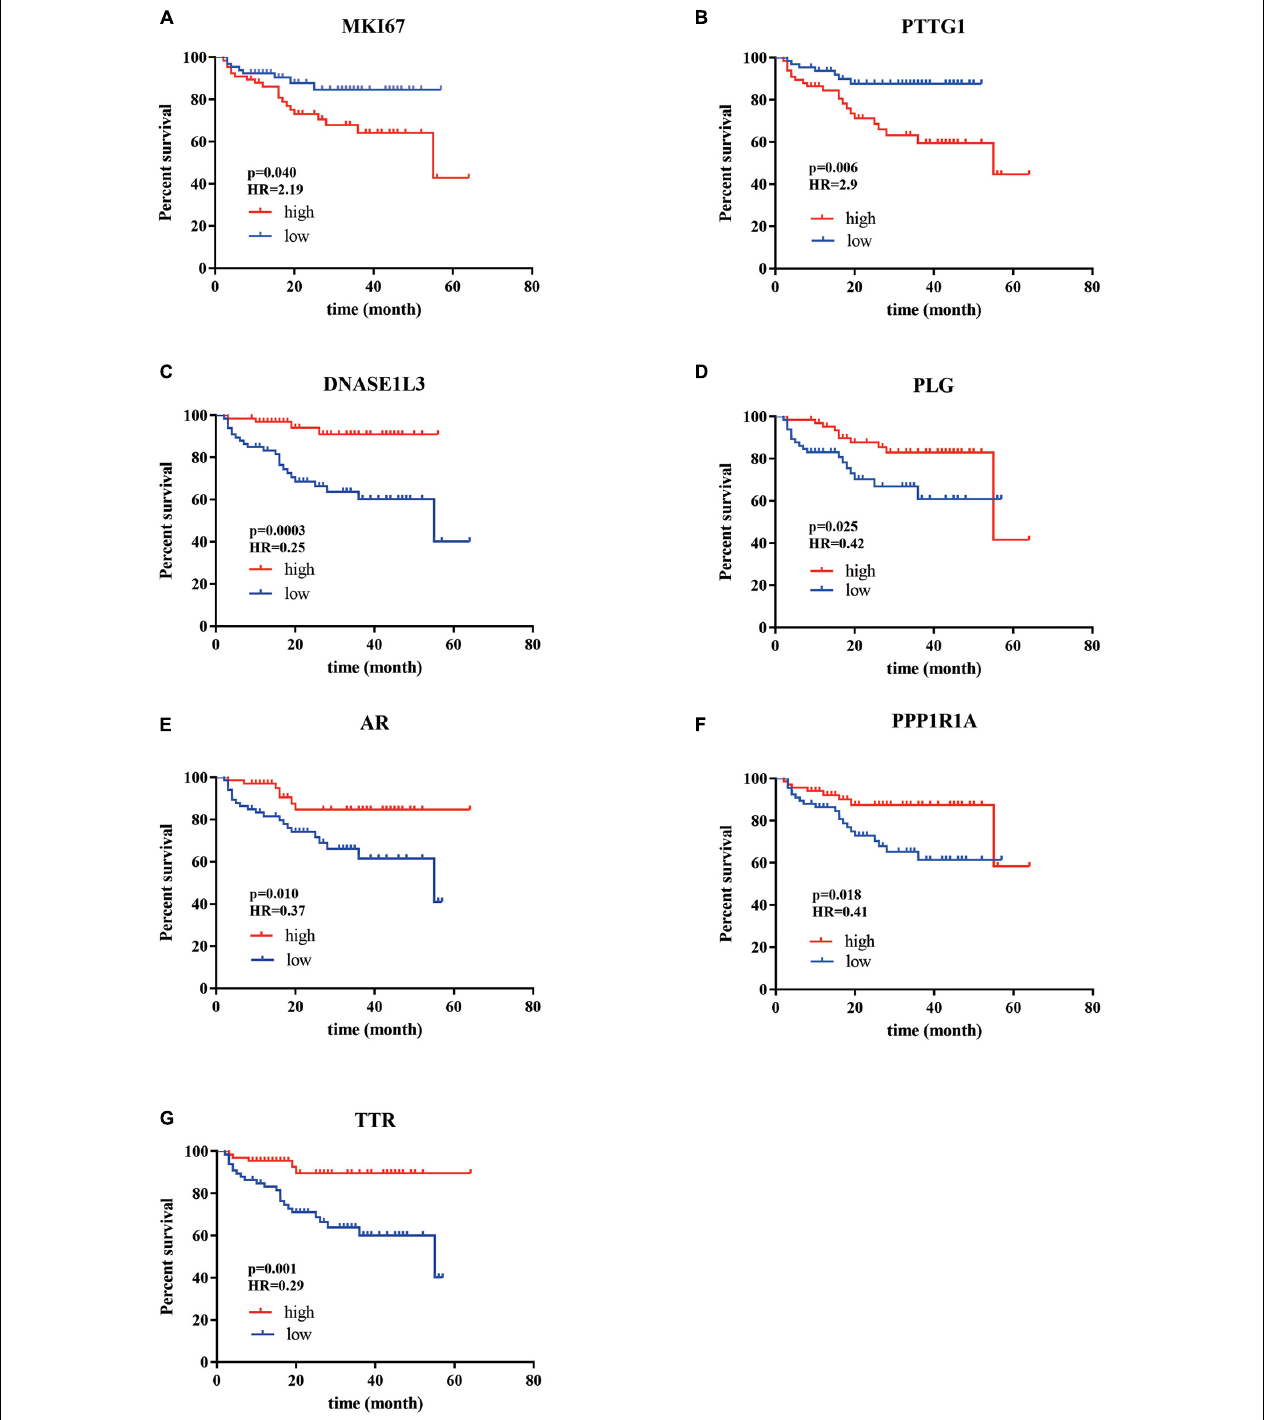
FIGURE 1 | The Kaplan–Meier analysis identified relevant prognostic genes from patients with HCC after radical resection. (A) MKI67 ; (B) PTTG1 ; (C) DNASE1L3 ; (D) PLG ; (E) AR ; (F) PPP1R1A ; (G) TTR . The red lines indicate cases with high expression (expression value > median), while the blue line indicates cases with low expression (expression value < median). HR, hazard ratio; MKI67 (a marker of proliferation Ki-67), PTTG1 ( PTTG1 regulator of sister chromatid separation, securin), DNASE1L3 (deoxyribonuclease 1 like 3), PLG (plasminogen), AR (androgen receptor), PPP1R1A (protein phosphatase 1 regulatory inhibitor subunit 1A), and TTR (transthyretin). P -values were obtained from the log-rank